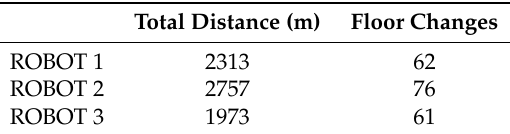
Table 7. Robots’ overall trip